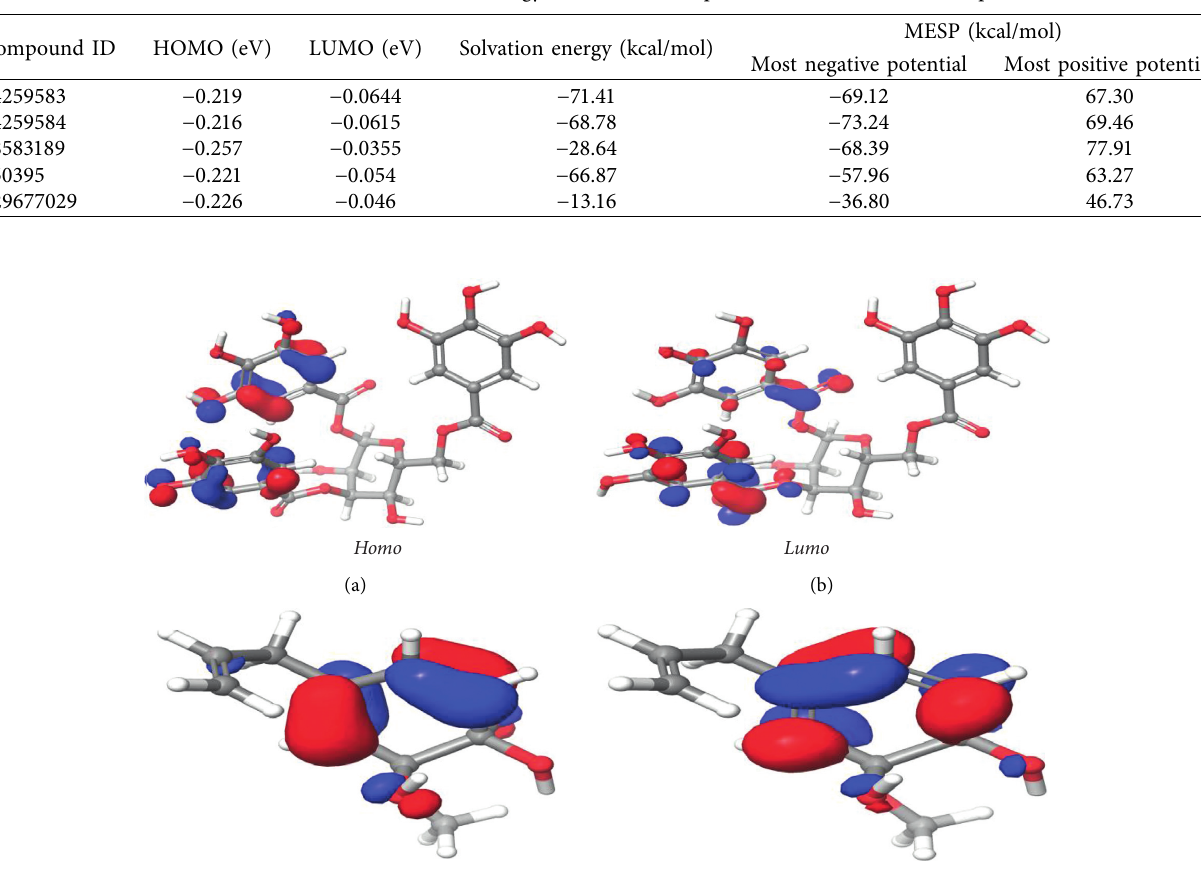
Table 4: HOMO, LUMO, solvation energy, and MESP of top hit Kabasura Kudineer